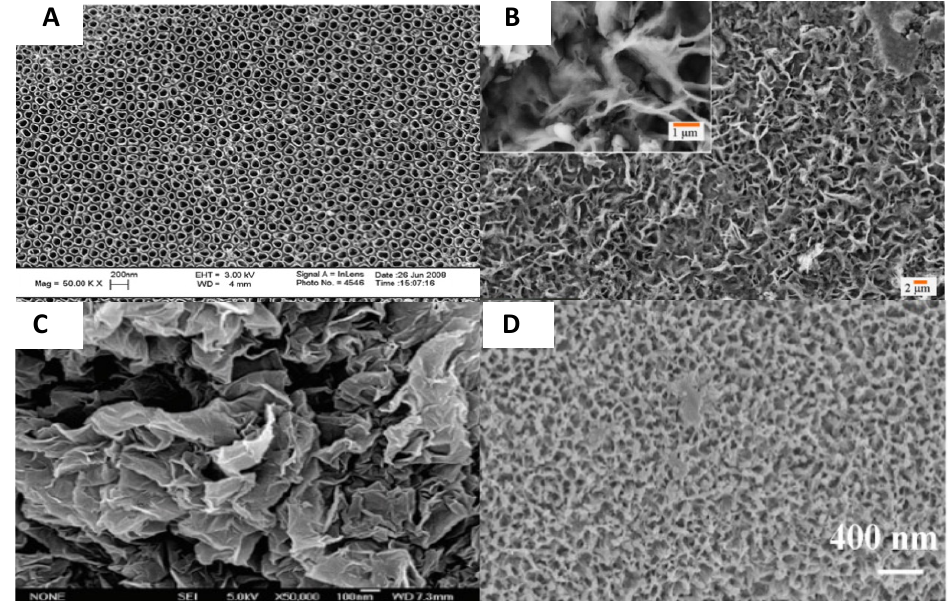
Figure 6. Architectural representation of various bactericidal or repellent surface engineering strategies outlined in Section 7. ( A ) Nanotubular Ti after anodization, adapted with permission from [220]. ( B ) Multilevel (micro- and nano-) roughened aluminium alloys adapted from [221] under CC BY 4.0 http://creativecommons.org/licenses/by/4.0/ (accessed on 18 October 2022). ( C ) Reduced graphene oxide (rGO) nanosheets on silicon wafer adapted with permission from [222]. ( D ) Hyperbranched poly-L-lysine coating on Ti implant adapted with permission from [223].